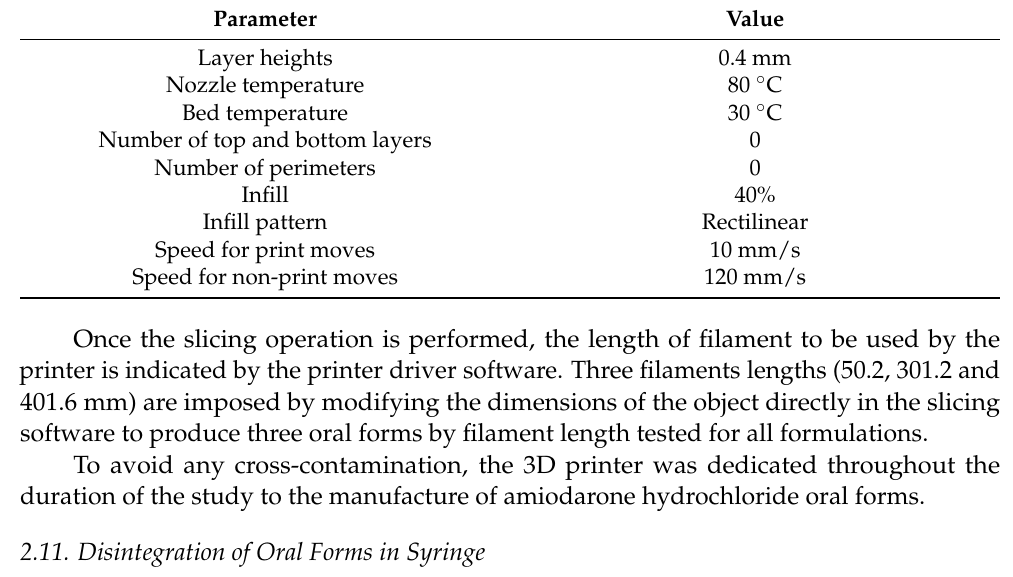
Table 3. Three-dimensional printing slicing settings. Parameter Value Layer